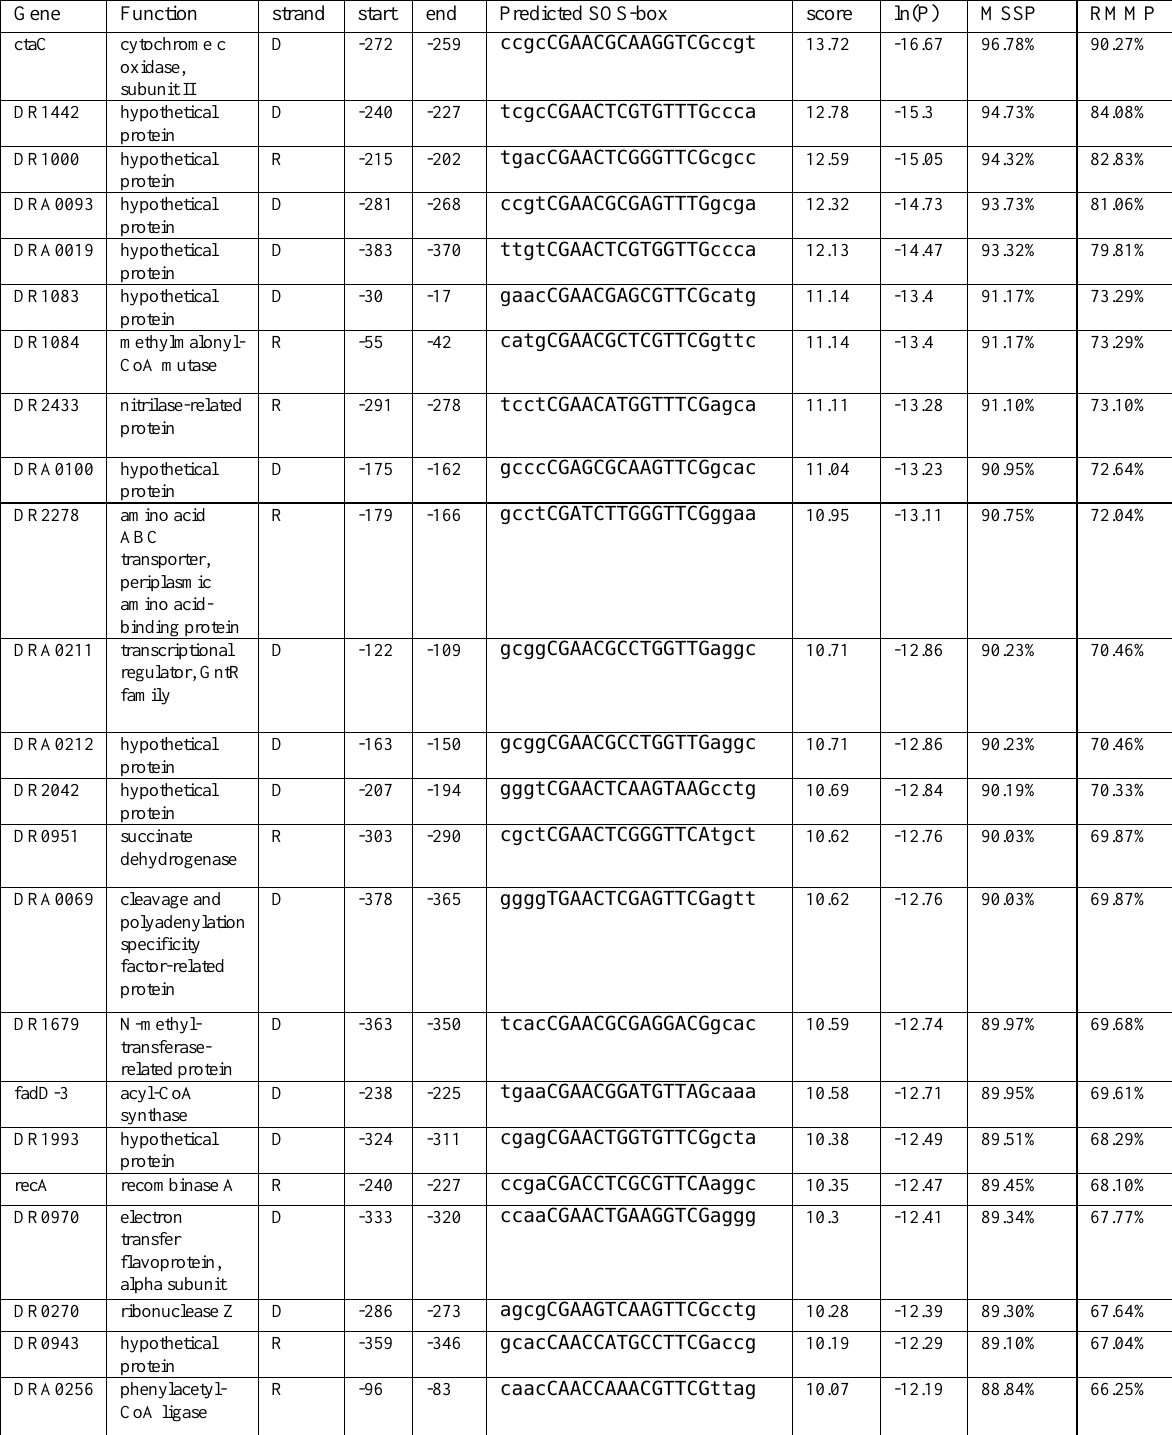
Supplementary Table 13 (S13): Genome wide top hits for LexA TFBS in the upstream sequences of D. radiodurans genome at lower threshold cut off 88.21% MSSP using weight matrix alone. Only few genes belongs to DNA repair and stress response family were predicted through this